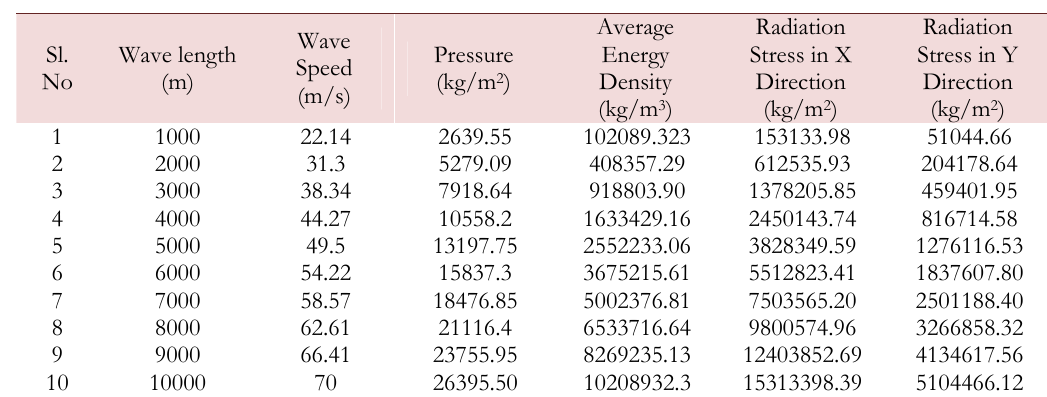
Table 3: Mathematical Characteristics of Wave in Shallow Water.